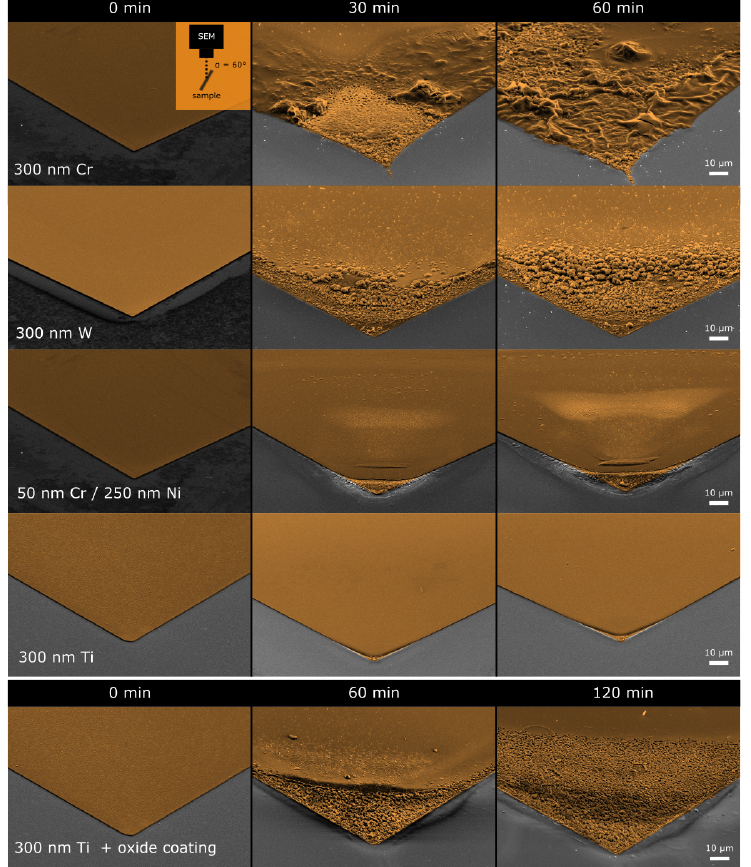
Figure 2. Erosion study to find a suitable material for the SDBD electrodes. The SEM images of the MEMS-fabricated SDBD electrodes taking at an inclination angle of α = 60° and displayed in false color. The left column presents the electrodes directly after the fabrication with indication of their materials or material combinations. The other columns shows the electrodes after SDBD operation by a V rms = 2.2kV sine wave with a frequency of f = 1kHz during the time displayed in the column’s